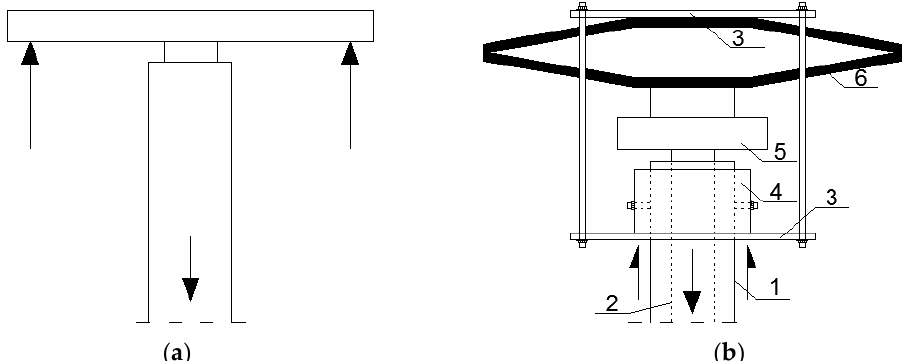
Figure 7. Concept of traditional static load tests ( a ) and scheme of bi-directional tests ( b ), 1: uplifted steel pipe, 2: compressed pole of dynamic probe, 3: frame composed by the two flat plates and four threaded bars, 4: steel collar attached to the pile head with three horizontal set bolts 5: load cell, 6: manual jack.